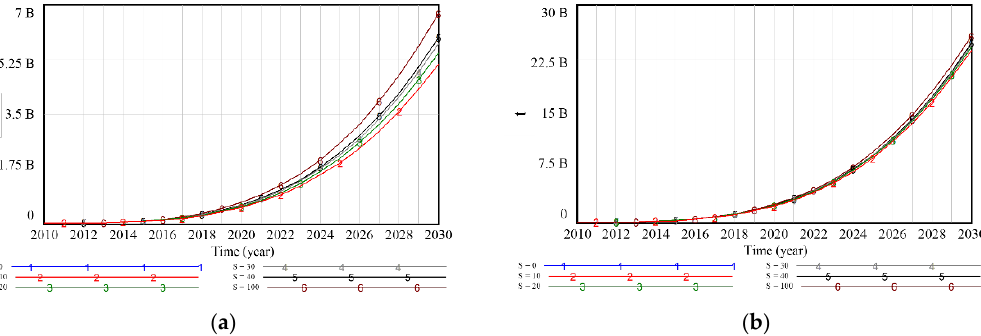
Figure 7. Effect of different subsidies on the amount of recycling. ( a ) Total recycling. ( b ) Environmental benefit.